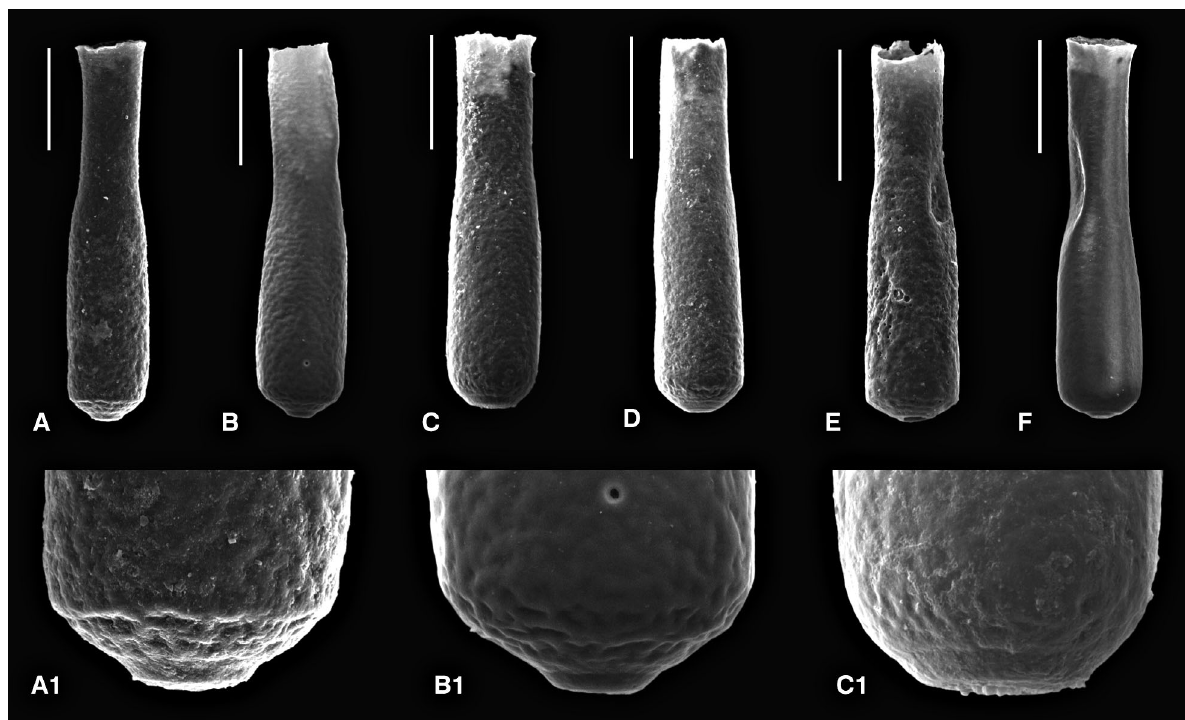
Fig. 3. Conochitina viruana sp. nov. A , A1 , holotype, GIT 718-4, Velise (F-97): 209.20–209.28 m (365  80  55 µm); B , B1 , GIT 718-5, Saare (K-20): 108.7 m (321  78  52 µm); C , C1 , GIT 718-6, Saare (K-20): 108.4–108.5 m (325  79  71 µm); D , GIT 718-7, Saare (K-20): 109.6–109.8 m (309  74  51 µm); E , GIT 718-8, Velise (F-97): 209.2 m (279  71  56 µm); F , GIT 718-9, Conochitina cf. viruana , smooth specimen with gentle flexure, Virtsu (309): 248.3–248.4 m (334  76  60 µm). The scale bars correspond to 100